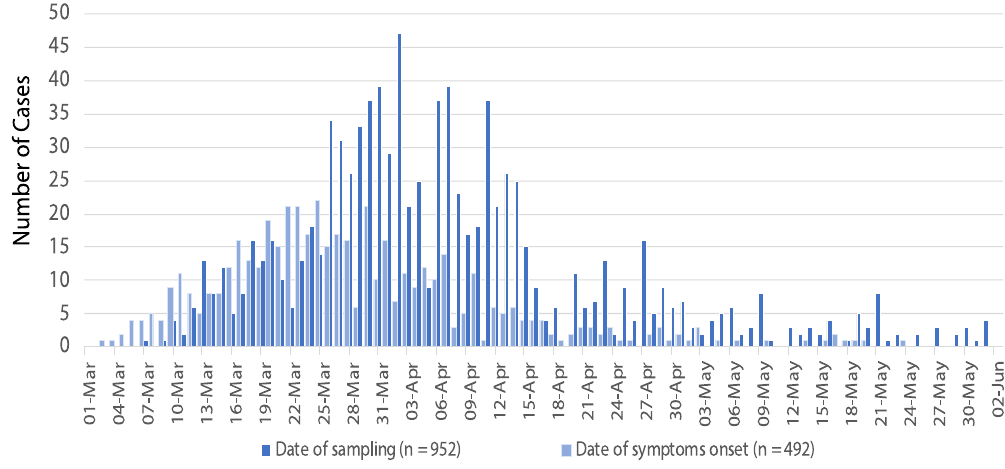
Figure 1. The epidemic curve by date of sampling and date of symptom onset during the observation period.